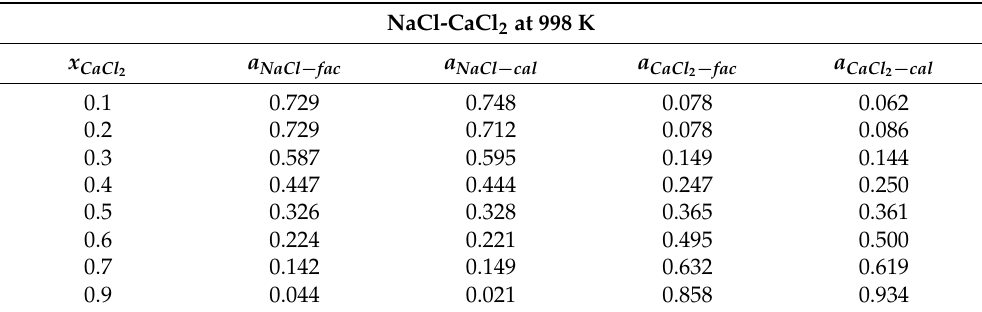
Figure 10. Comparison of the calculated activities and literature data of each element of the NaCl-CaCl 2 system (998 K). Table 2. Calculated activity values and FactSage data of the NaCl-CaCl 2 binary chloride system at 998